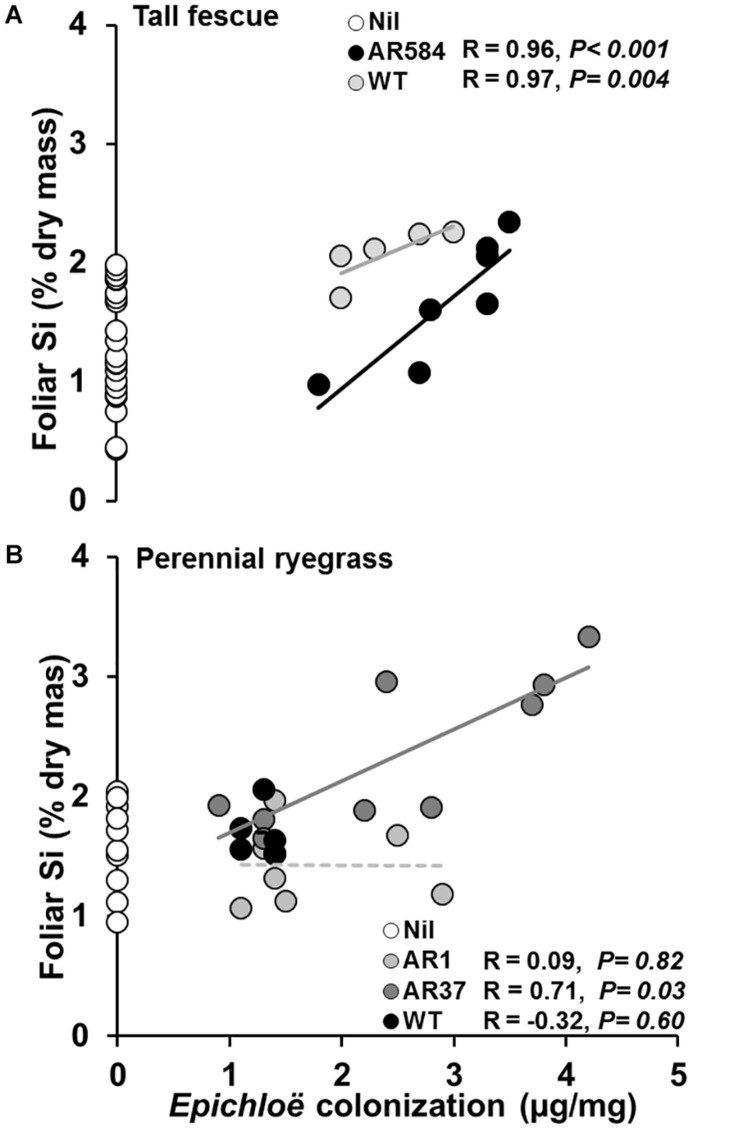
Relationships between Epichloë endophyte colonization and foliar Si concentration in (A) tall fescue and (B) perennial ryegrass with (filled circles) and without (Nil, white circles) endophytes growing hydroponically in the presence of silicon (Si). Lines represent linear regression through data points for each endophyte strain tested. Significant and non-significant relationships represented as solid or dashed lines, respectively. White circles represent Si concentrations from control plants (Nil) confirming lack of endophyte infection and displaying variability of Si in foliar tissue.